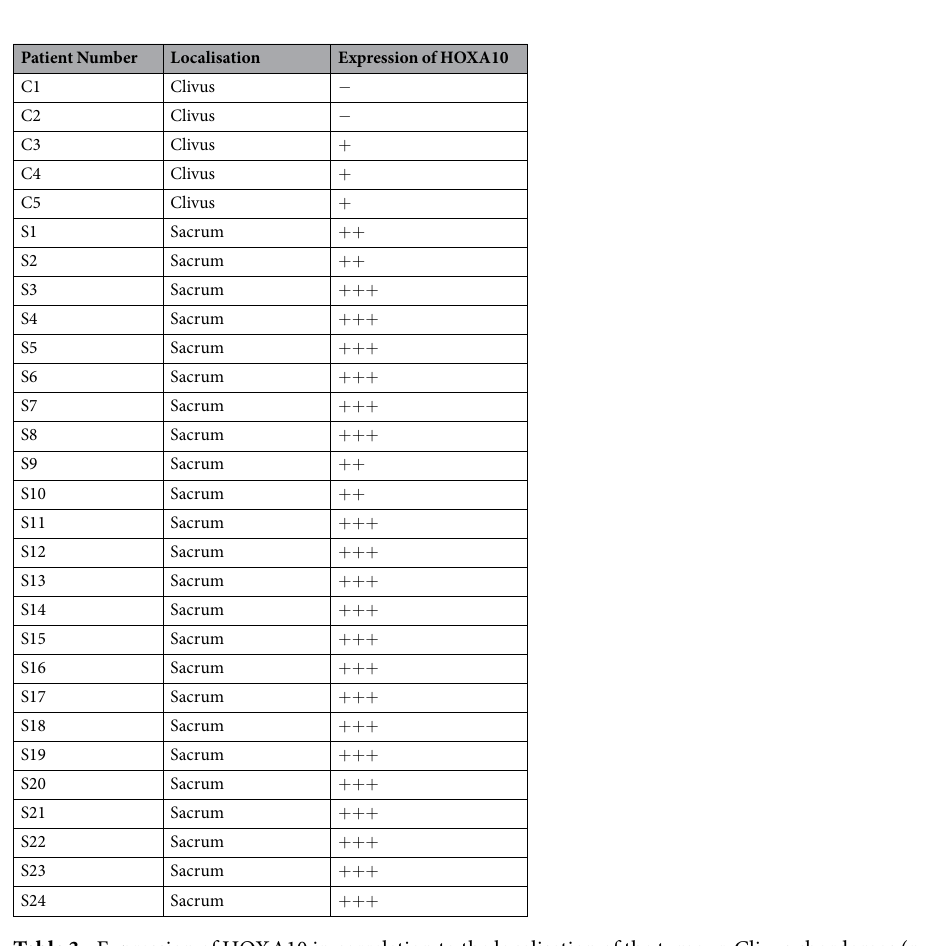
Table 3. Expression of HOXA10 in correlation to the localisation of the tumour. Clivus chordomas (n = 5) have a weaker expression of HOXA10 than sacrum chordomas (n = 24) shown by